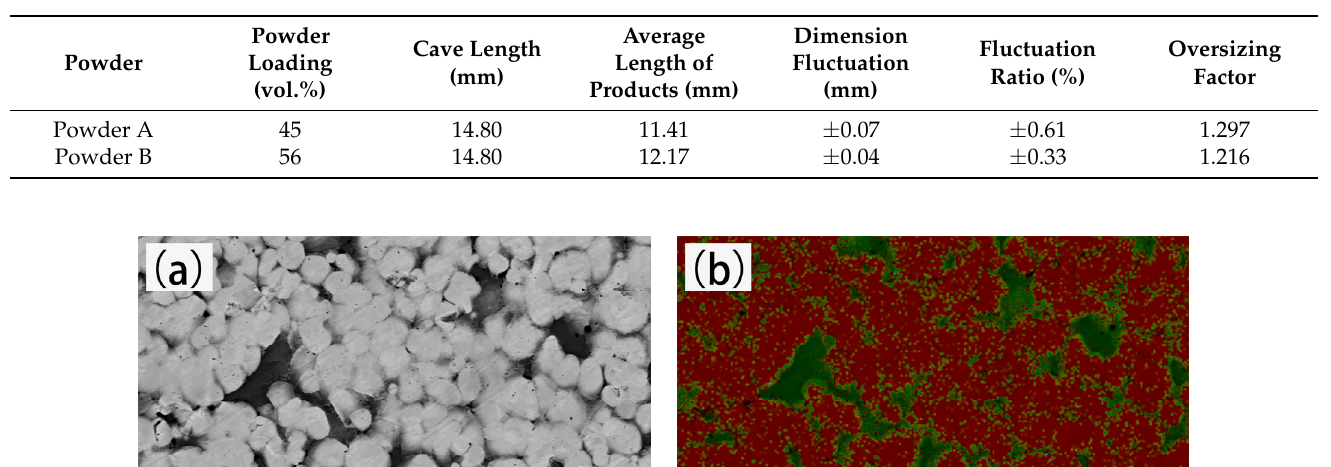
Table 3. Effect of powder loading on dimension precision and oversizing factor (OSF) of the supporter parts.